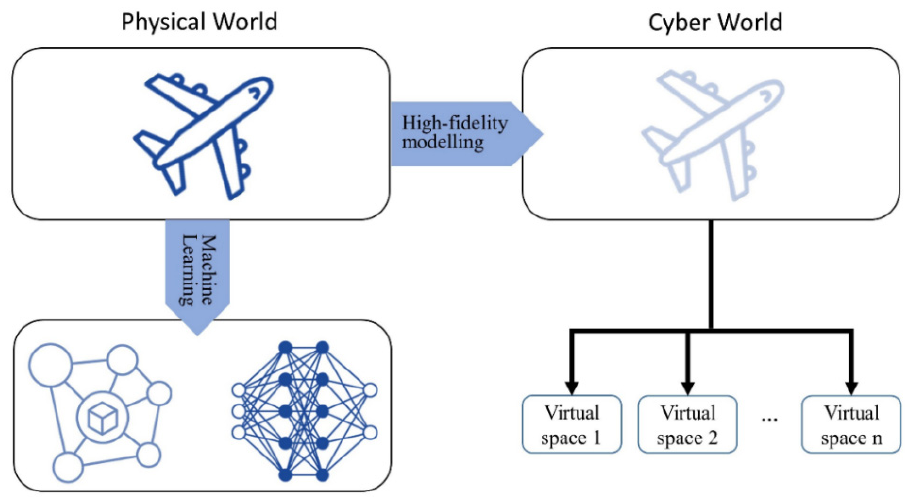
Figure 2. The comparison of Digital Twin (top-right) and Data Twin (bottom left).